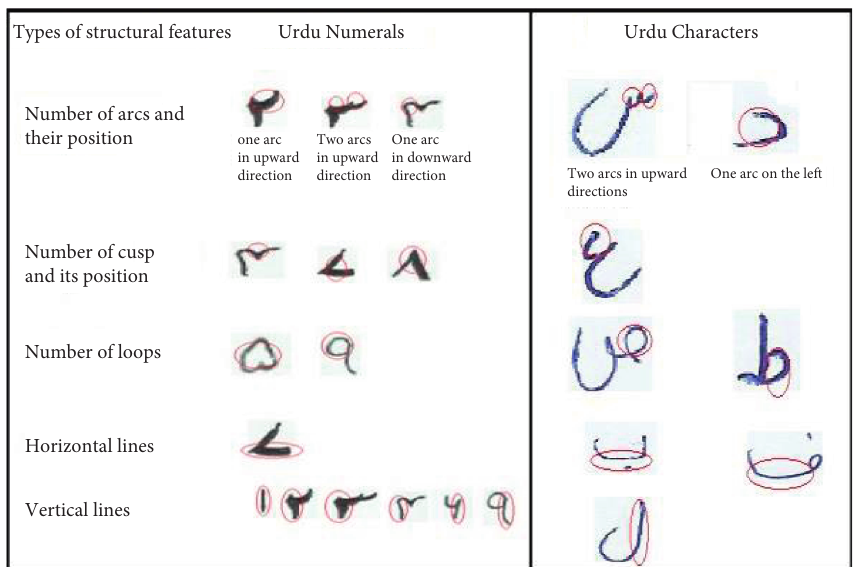
Figure 6: Types of structural features of Urdu numerics and